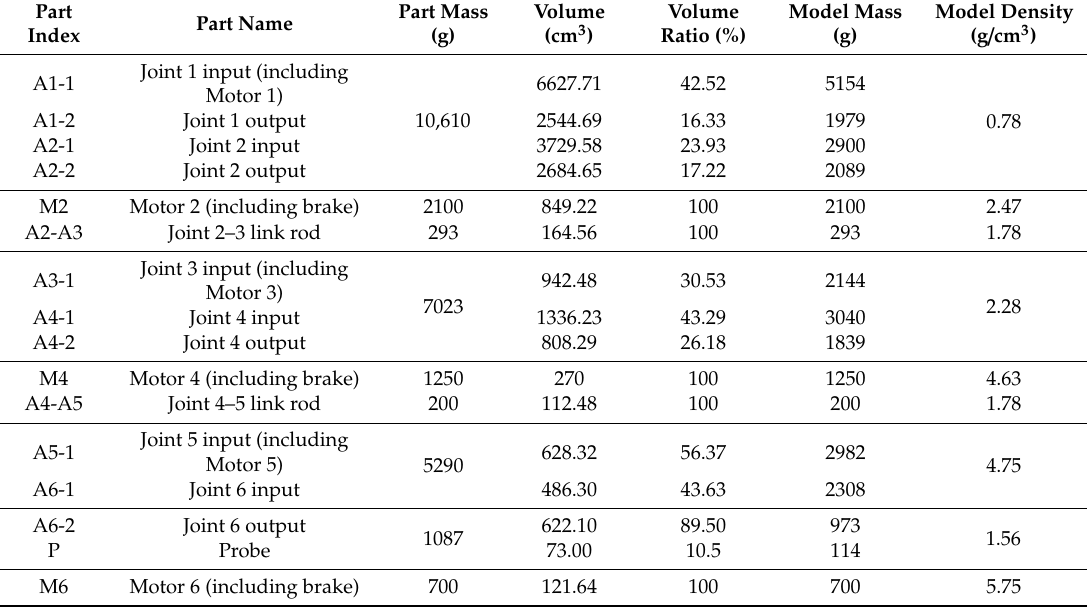
Table 3. 3D part mass distribution.